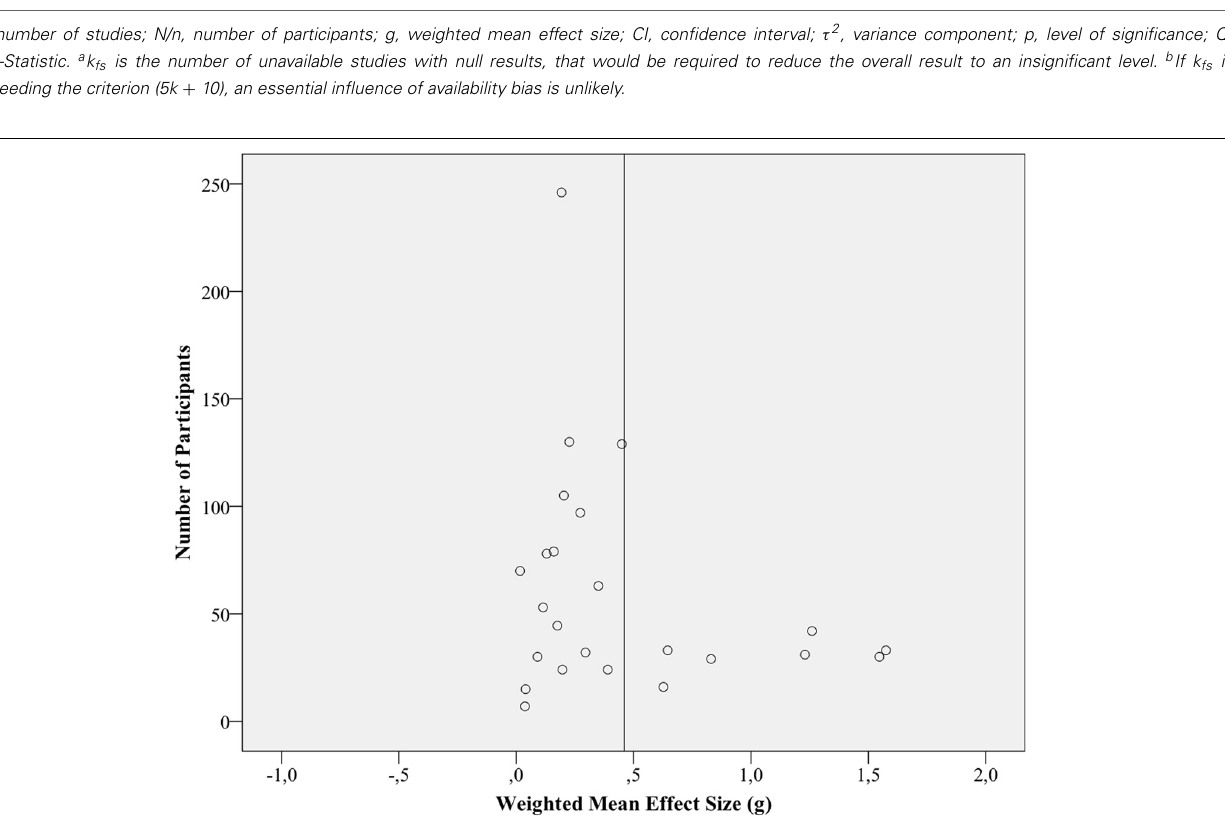
FIGURE 3 | Funnel plot of within-group effect sizes ( K = 24). The vertical bar represents the weighted (by sample sizes) mean effects